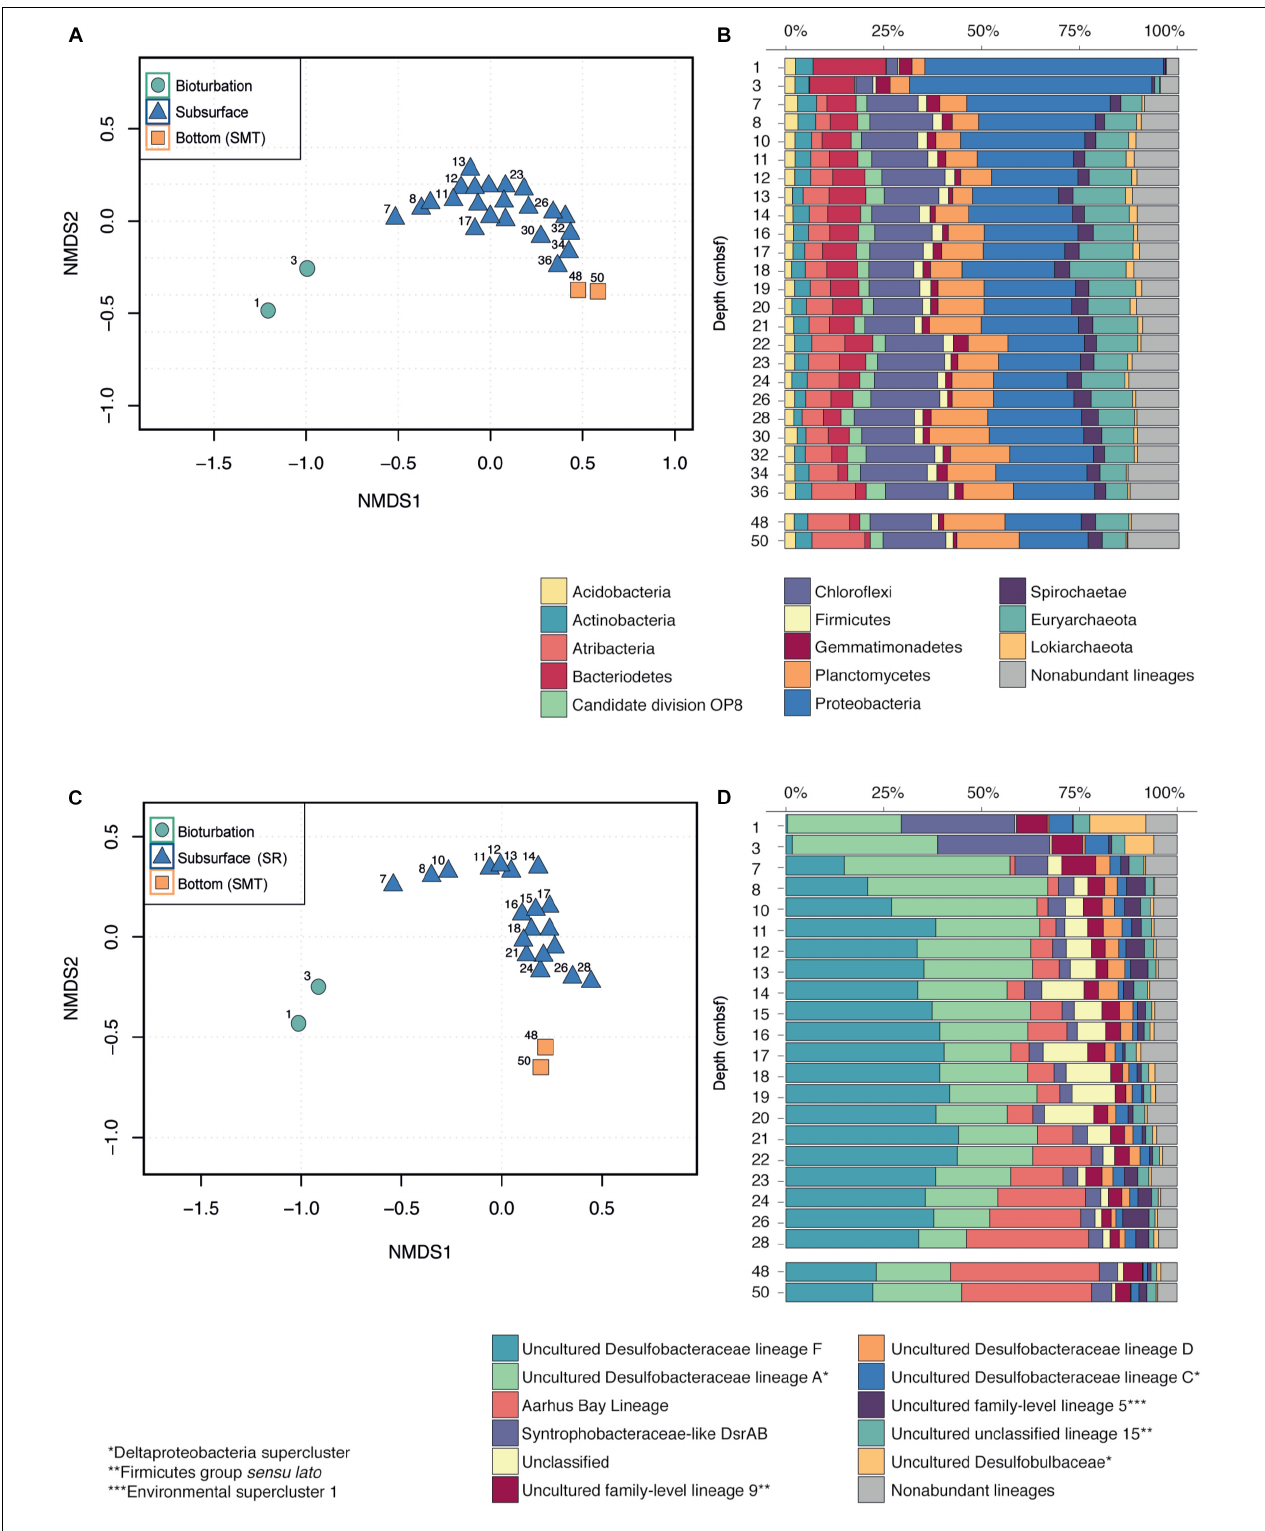
FIGURE 3 | Changes in the microbial community with depth. (A,C) Non-metric multidimensional scaling (NMDS) of subsampled sequencing datasets for all Bacteria and Archaea (A) and SRM lineages (C) . NMDS ordinations were calculated at the OTU level (B,D) Stacked bar plots of the relative sequence abundances for the total community (B) and the SRM lineages (D)